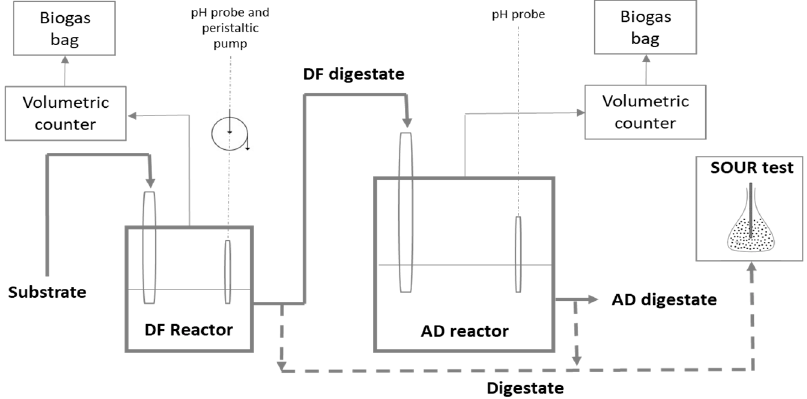
Figure 1. Schematic representation of experimental set-up.